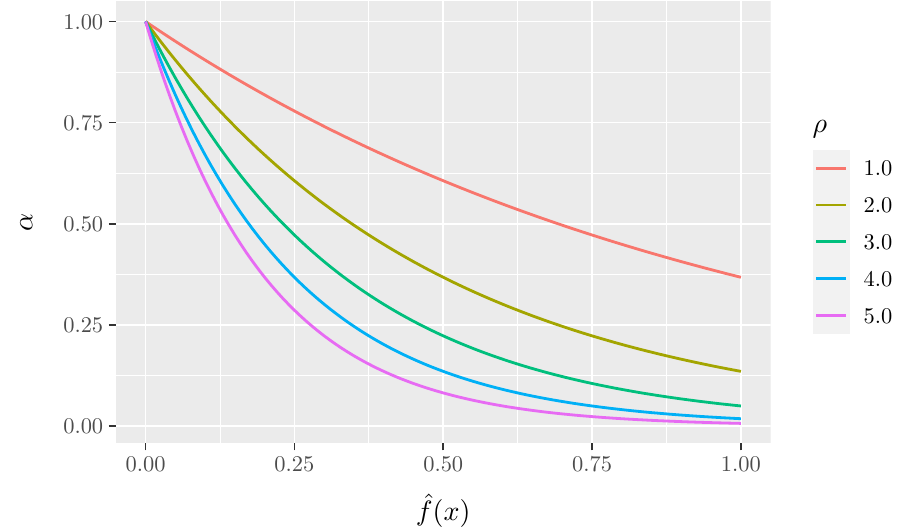
Figure 1. The α mutation curves at different values of ρ